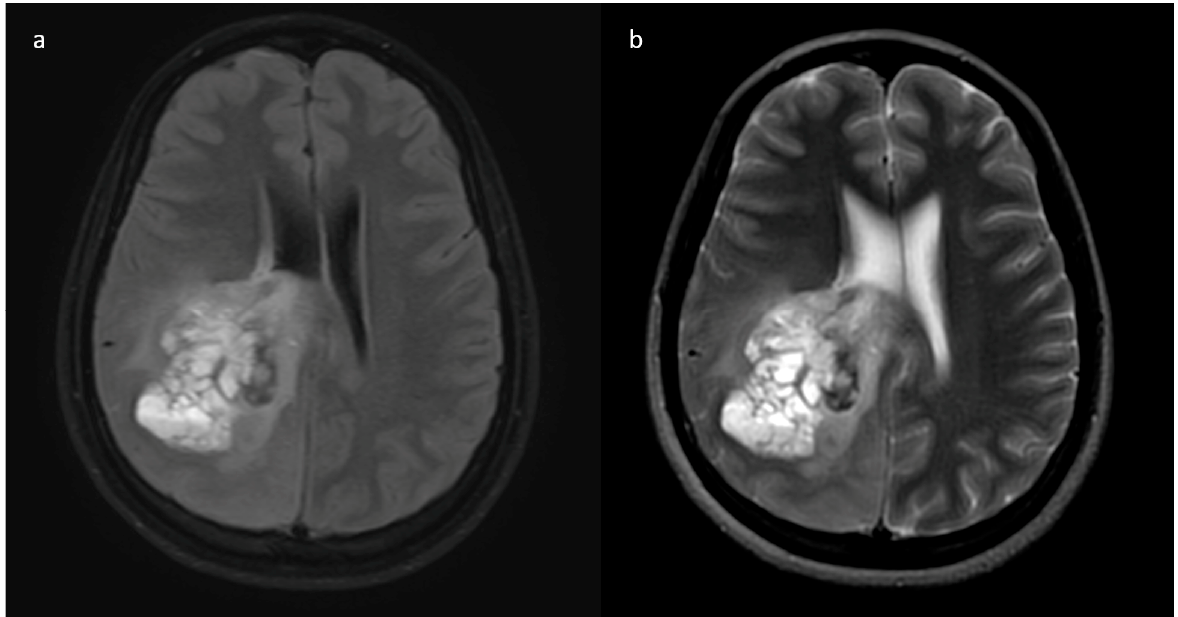
Figure 5. ( a , b ) Axial T2w and FLAIR images reveal intratumoral cysts with fluid-fluid levels within these cysts, suggestive of a hemorrhage.